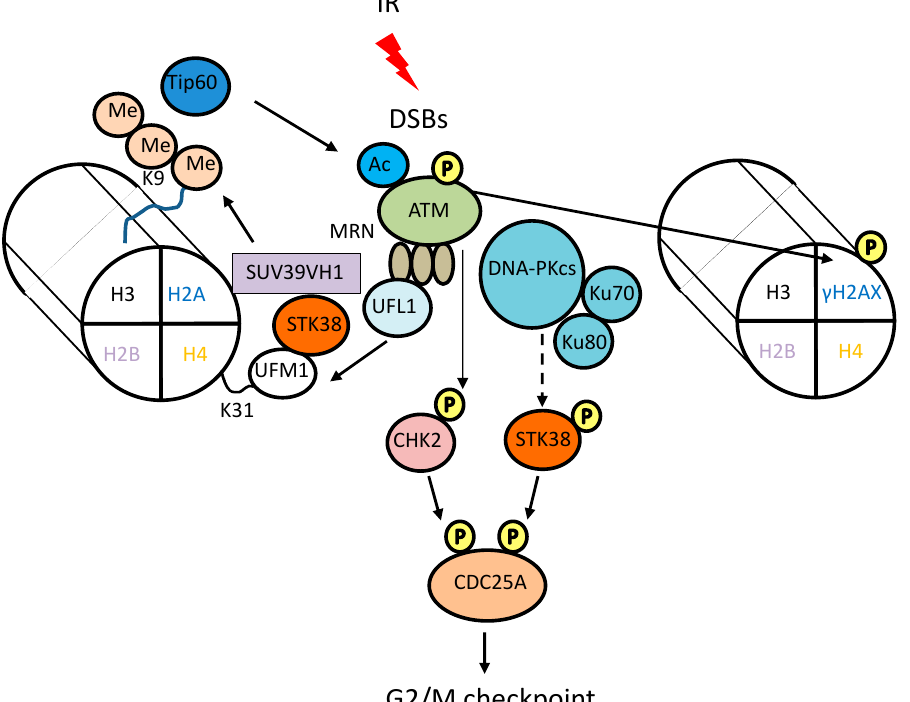
Figure 3. Involvement of STK38 in DNA damaging signaling. IR produces many DNA lesions, including DNA double-strand breaks (DSBs). DNA damage is recognized by sensor proteins such as the MRN complex. MRN complex recruits the signal-transducing kinase ATM and collaborates for its activation. UFM1-specific ligase 1 (UFL1) is recruited by the MRN complex and mono-ufmylates of the K31 residue of histone H4. STK38 has a UFM1 binding motif and binds to ufmylated H4, recruiting SUV39H1 to the DSB site, resulting in trimethylation of H3K9. The acetyltransferase Tip60 is activated in a histone H3K9me3-dependent manner and acetylates ATM, promoting to ATM activation [34]. Activated CHK2 by ATM phosphorylate S123 of CDC25A, accelerating its degradation through the ubiquitin–proteasome pathway, thus leading to G2 arrest. DNA-PK plays a vital role in the repair of DSBs. Knockdown of DNA-PKcs suppresses phosphorylation of STK38 activation segment site, S281. Activated STK38 by IR phosphorylates S76 of CDC25A, leading to subsequent degradation of CDC25A and activation of G2/M checkpoint. Me and Ac indicate methylation and acetylation,